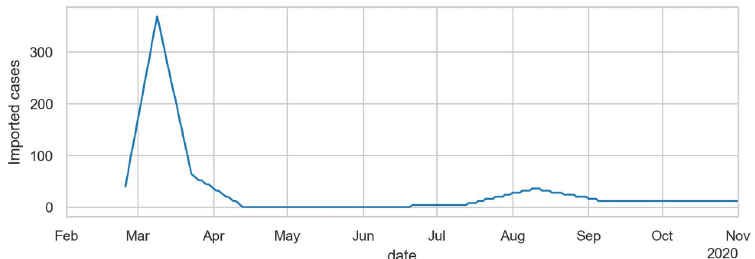
Fig 5. Disease import over time. Based on data taken from [77] (always on Tuesdays), but multiplied by 4 in spring, and divided by 2 in summer (see text for Discussion).